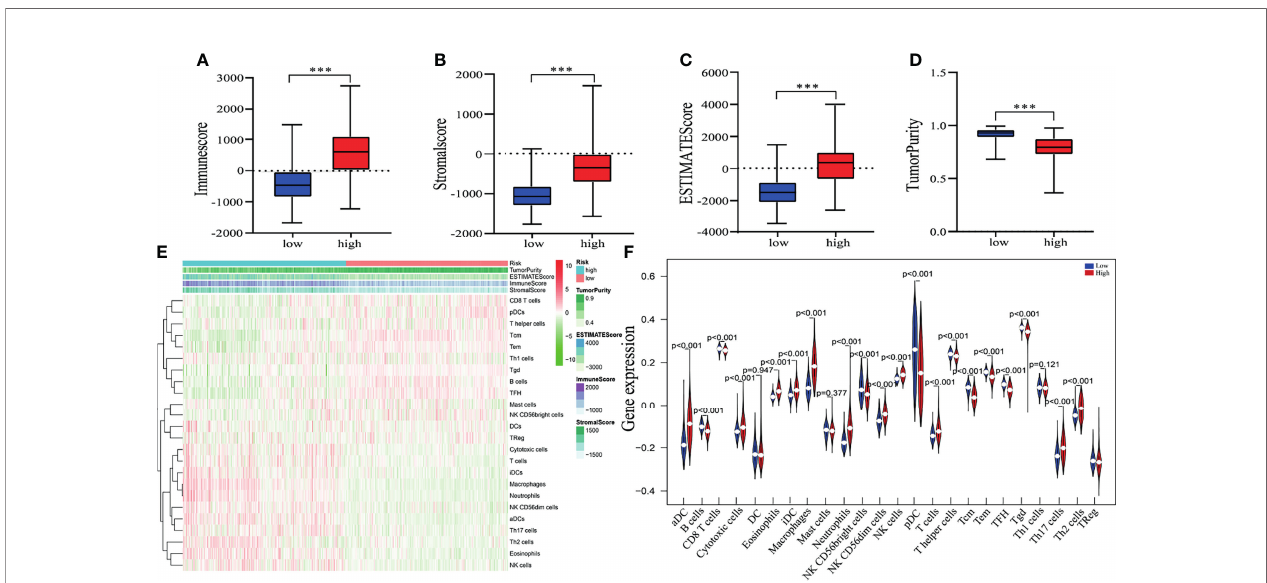
FIGURE 6 | Estimating tumor purity and TIIC (tumor-in fi ltrating immune cell) components. (A – D) There was a signi fi cant difference in the immune score (A) , stromal score (B) . ESTIMATE score (C) and tumor purity (D) between high- and low-risk patient groups. *** p < 0.001. (E) The heatmap shows the tumor purity, corresponding immune cell in fi ltrates, immune score, ESTIMATE score and stromal score for each glioma patient in the two risk groups. (F) The vioplot revealed the different proportion of each immune cell between the two risk groups (blue was the low-risk group, and red was the high-risk